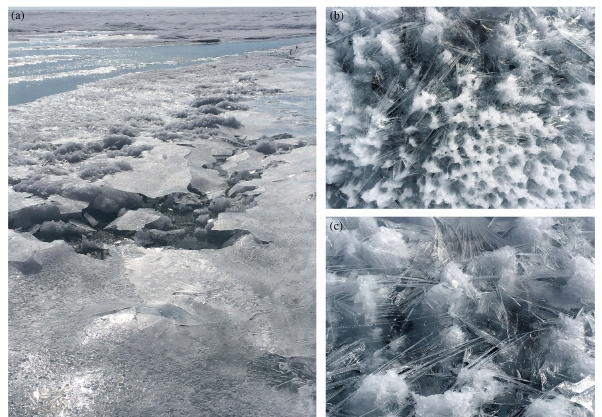
Figure 9. Night-time refreezing of meltwater at the surface of (a) water tracks ( ∼ 10m length scale), and (b) cryoconite holes ( ∼ 0.1–1m length scale) was frequently observed during the field study. Photos were collected by the first author during the 6– 12 July 2016 field campaign between 04:00 and 07:00 local